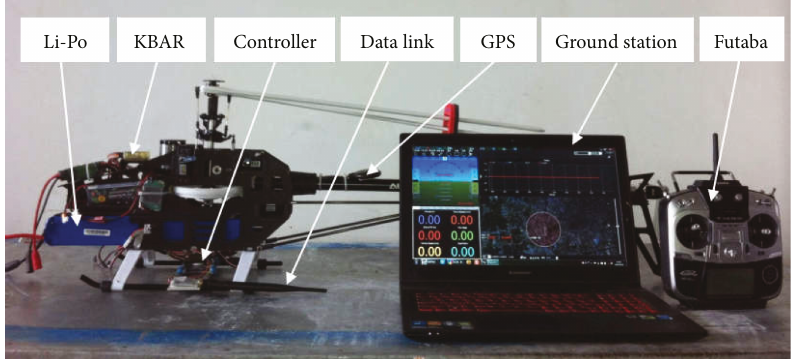
Figure 2: The unmanned helicopter experimental